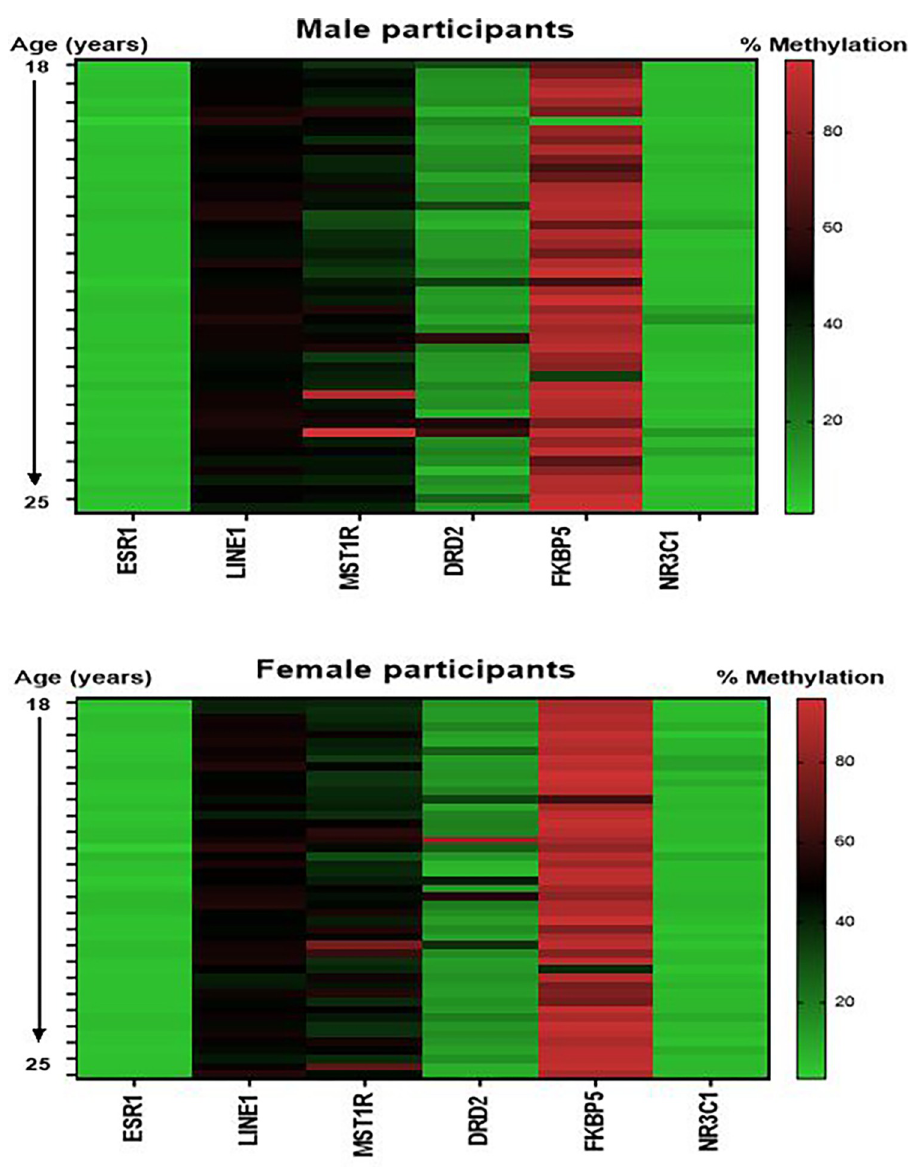
Fig 1. A heat map of DNA methylation. The percentage of DNA methylation levels at promoter CpG Island were analyzed in bisulfite-modified genomic DNA extracted from saliva from 98 African American young adults (Females = 50, Males = 48; Age 18–25 years old) using pyrosequencing. Top graph is samples from males and bottom is samples from females. Percentage (%) scale is shown to the right and samples are arranged by age from top to the